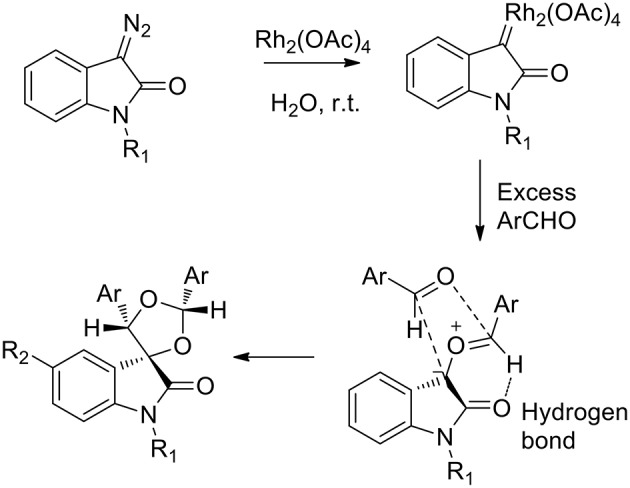
Proposed mechanism.